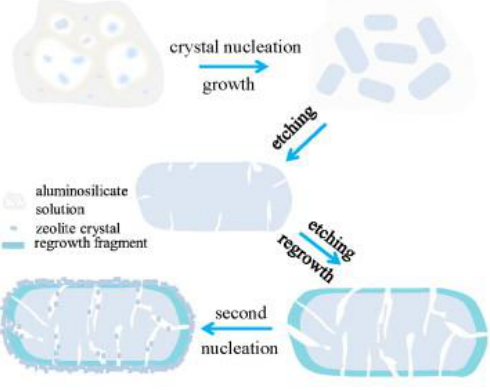
Figure 11. The mechanism for the formation of HSZs [76]. Copyright Elsevier, 2015.